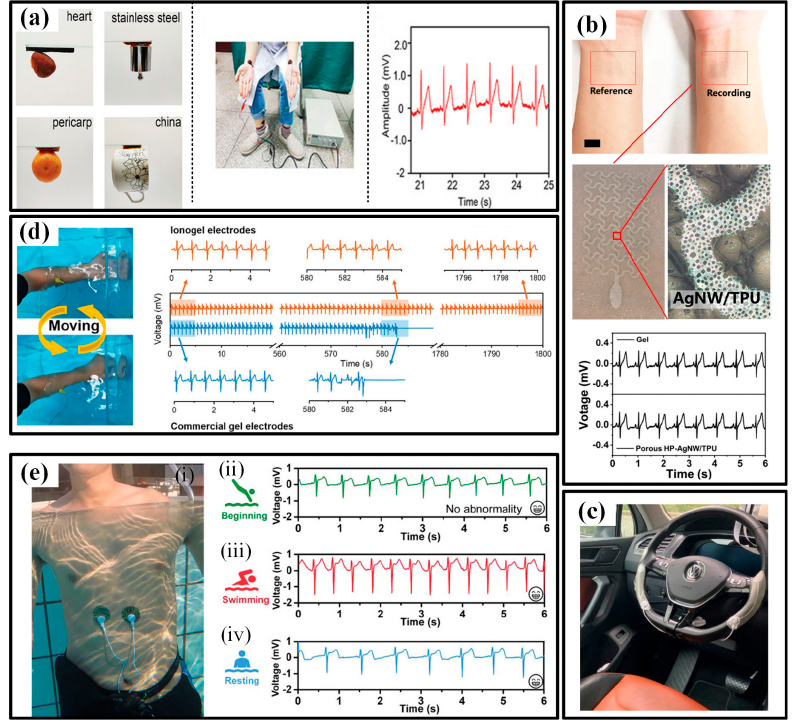
Figure 12. The wearable ECG devices and their applications in sport monitoring: ( a ) the electrodes with long-term and repeatable adhesiveness (left) and the electrodes worn on forearms (middle) to capture ECG signals (left) [70] ; ( b ) the electrodes with porousness for excellent permeability (up) and the captured ECG signals (down) [136] ; ( c ) the steering wheel with flexible ECG electrodes [137] ; ( d ) the water-resistant electrodes and the long-term reliability underwater [141] ; ( e ) the water-resistant conformal hybrid electrode for aquatic endurable ECG monitoring during swimming [32] . Reproduced with permissions from Wiley (2020)[32]. Reproduced with permissions from Wiley (2019)[70]. Reproduced with permissions from American Chemical Society (2020)[136]. Reproduced with permissions from Wiley (2021)[141].